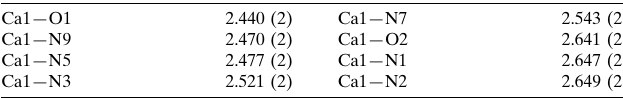
Selected bond lengths (A˚ ).